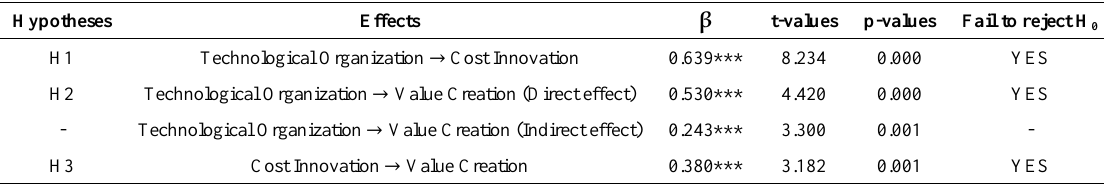
Figure 2. Result of the Structural Model Table 6. Summary